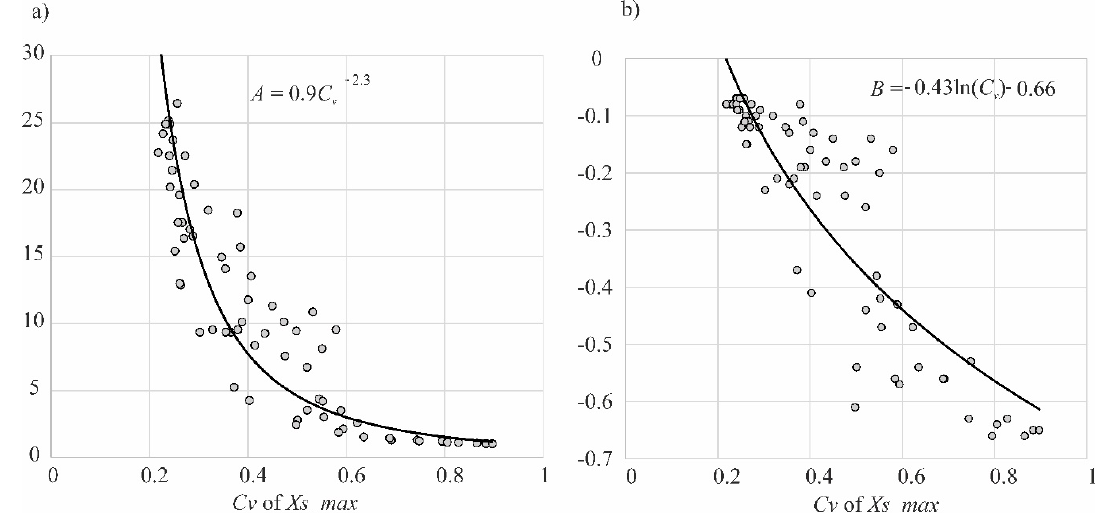
Figure 14. Effect of variability of maximum daily surface runoff X s_max on the parameter A ( a ) and B Figure 14. E ff ect of variability of maximum daily surface runo ff X s_max on the parameter A ( a ) and B ( b ) ( b ) of the exponential changes in duration of daily runoff X s (Equation (20)). of the exponential changes in duration of daily runo ff X s (Equation (20)).